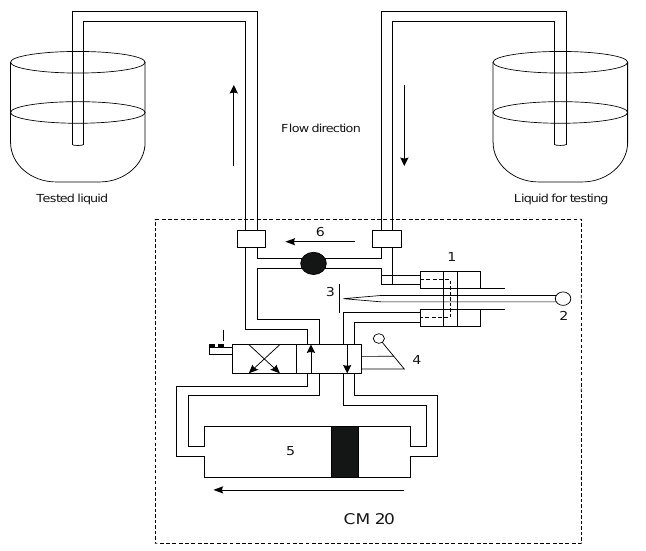
Figure 2. Diagram of the measuring system, 1—measuring chamber, 2—laser light source, 3—optical scanner, 4—switching valve (hydraulic), 5—dosing pump, 6—flow sensor.